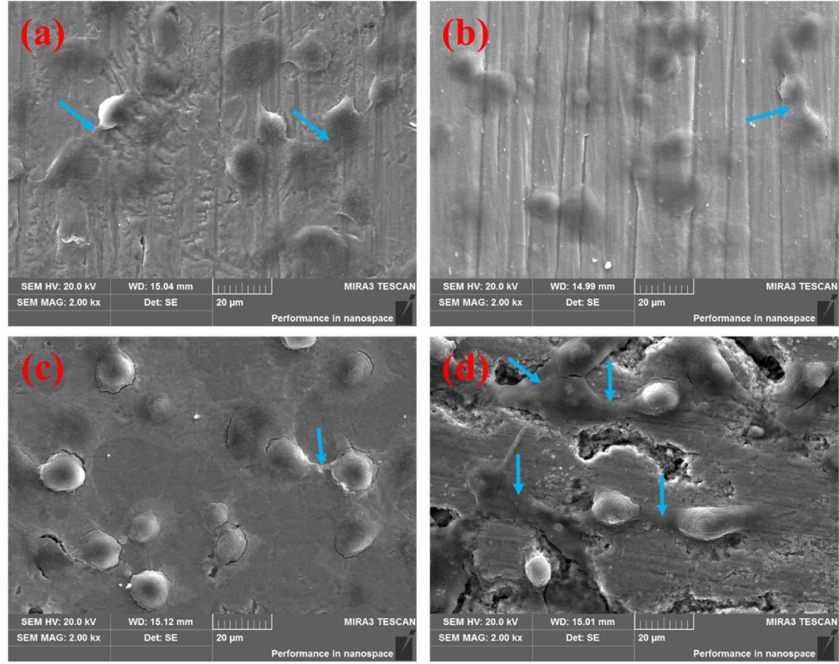
Figure 2. SEM images of surfaces of the different specimens after cell culture for 12 h with the blue arrows showing the pseudopodia between cells: ( a ) Ti, ( b ) Ti6Al4V, ( c ) boronized Ti6Al4V, and ( d ) boronized Ti6Al4V/HA